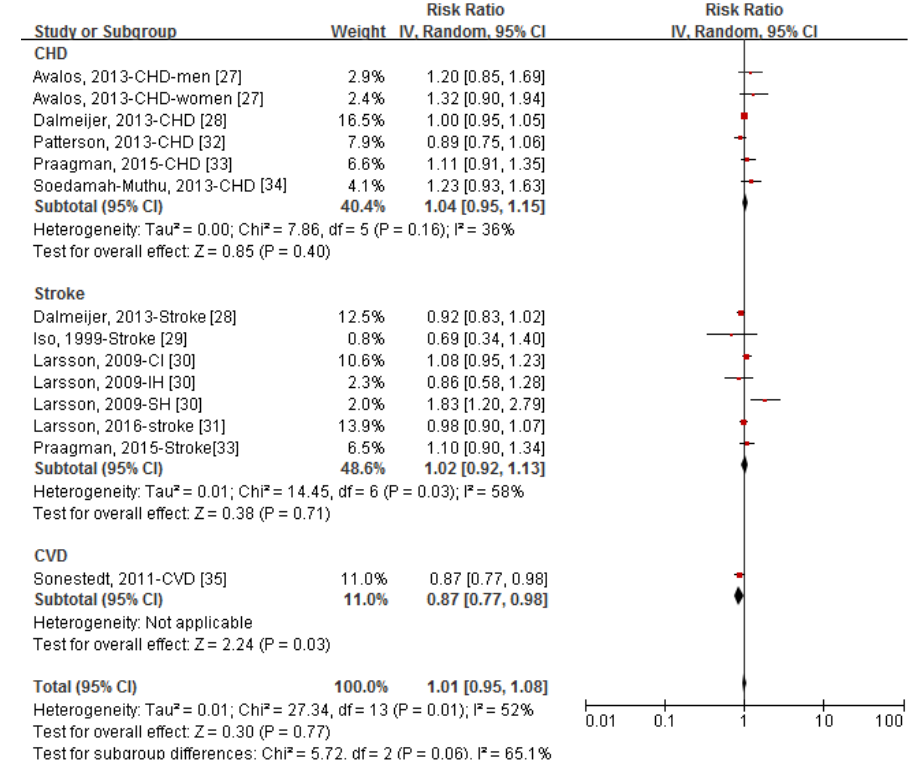
Figure 2. Forest plot of relative risks (RRs) and 95% confidence intervals (CIs) for the association between category of yogurt intake (highest vs. lowest) and the incident risk of coronary heart disease (CHD), stroke, and cardiovascular disease (CVD). CI, cerebral infarction; IH, intra-cerebral hemorrhage; SH, subarachnoid hemorrhage.